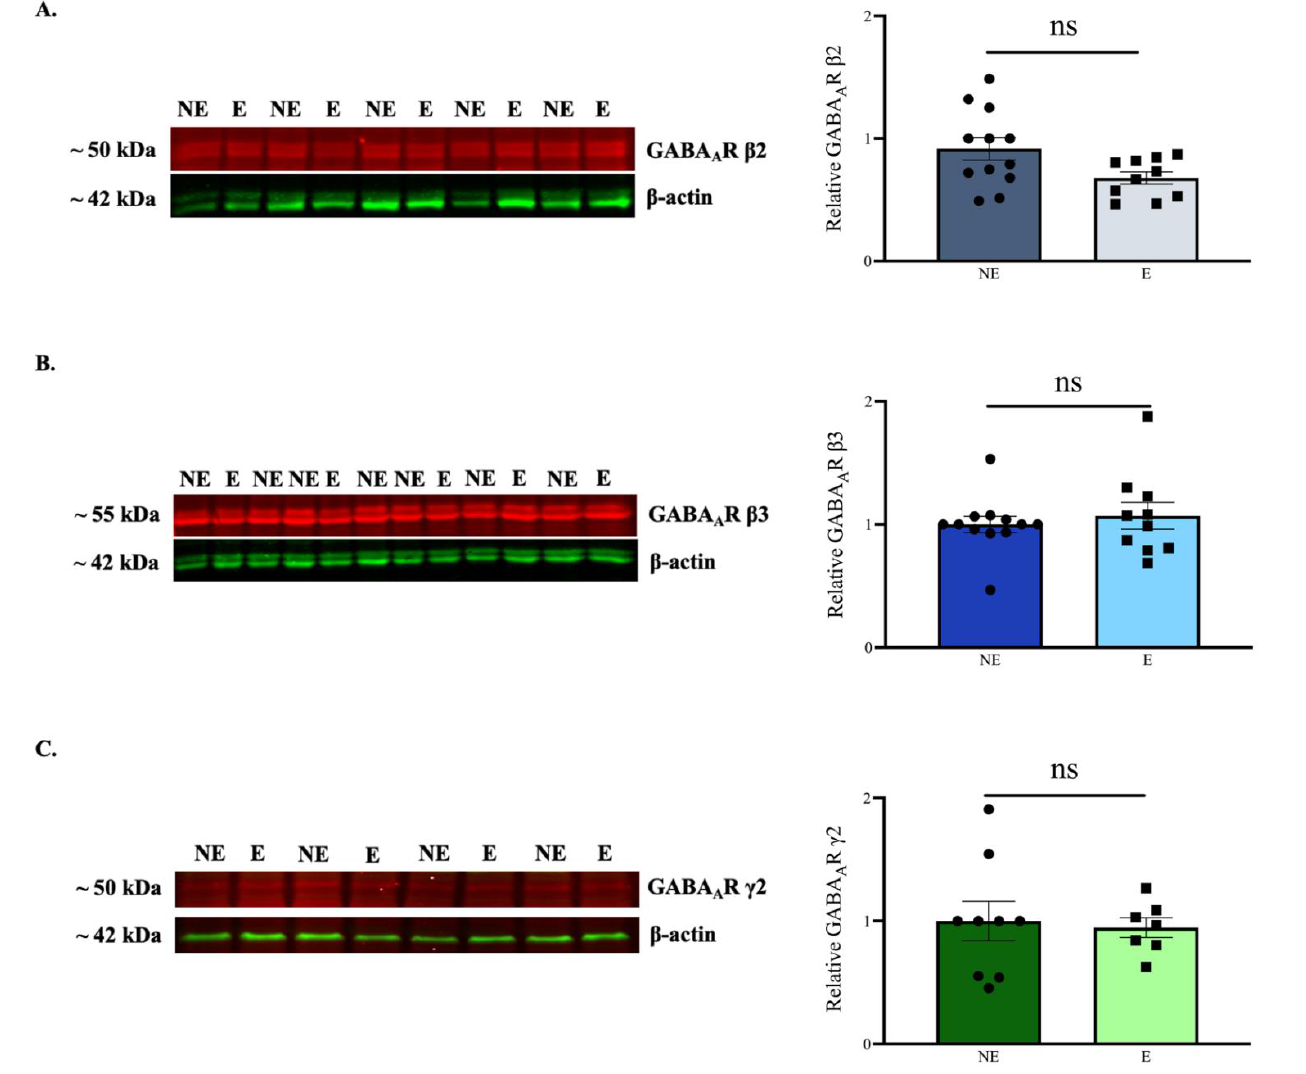
Figure 4. WB analysis for GABA A R β2, β3 , and γ2 subunits in the primary SoCx. The data compare expression between control (NE) littermates and epileptic (E) stargazers. ( A – C ) Representative blots display tissue expression of GABA A R β2, β3 , and γ2 subunits in the primary SoCx with β -actin as the loading control. Bar graphs represent the relative expression levels of GABA A R β2, β3 , and γ2 subunits, respectively. Bar graphs show a lack of statistically significant change in whole-tissue primary SoCx expression levels for β2 ( NE: 0.917 ± 0.091 [ n = 12], E: 0.678 ± 0.050 [ n = 10]; p = 0.093), β3 ( NE: 1.000 ± 0.067 [ n = 12], E: 1.070 ± 0.109 [ n = 10]; p = 0.859), and γ2 ( NE: 1.000 ± 0.159 [ n = 9], E: 0.946 ± 0.079 [ n = 7]; p = 0.900). The significance threshold was set at 0 .05. ‘ns’ indicates no significant change found from analyses.